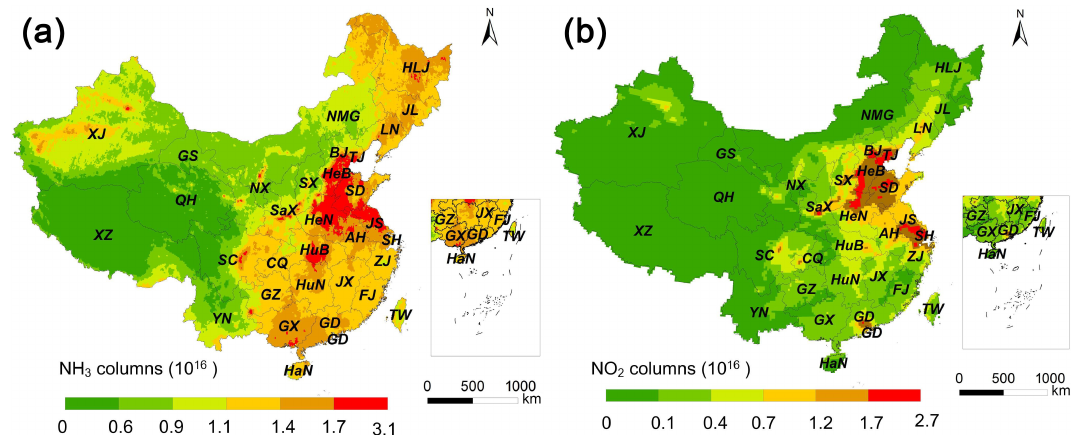
Figure 4. Spatial distribution of the annual NH 3 (a) and NO 2 (b) columns (moleculescm − 2 yr − 1 ) . The full provincial names are Beijing (BJ), Tianjin (TJ), Hebei (HeB), Shandong (SD), Shanxi (SX), Henan (HeN), Shaanxi (SaX), Liaoning (LN), Jilin (JL), Heilongjiang (HLJ), Neimenggu (NMG), Gansu (GS), Ningxia (NX), Xinjiang (XJ), Shanghai (SH), Jiangsu (JS), Zhejiang (ZJ), Anhui (AH), Hubei (HuB), Hunan (HuN), Jiangxi (JX), Fujian (FJ), Guangdong (GD), Hainan (HaN), Yunnan (YN), Guizhou (GZ), Chongqing (CQ), Sichuan (SC), Guangxi (GX), Xizang (XZ) and Qinghai